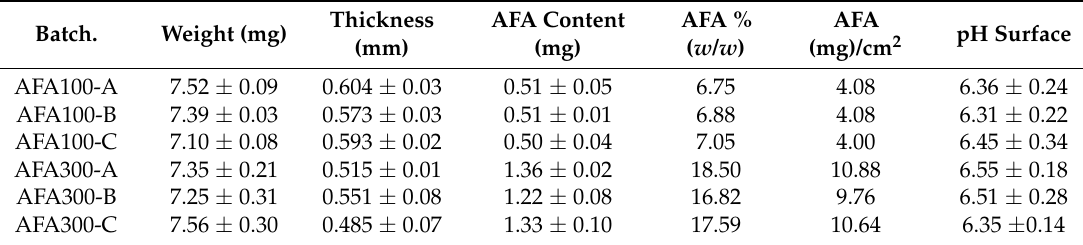
Table 1. Film weight, thickness and drug loading of 0.125 cm 2 disks (means ± SD). Batch.